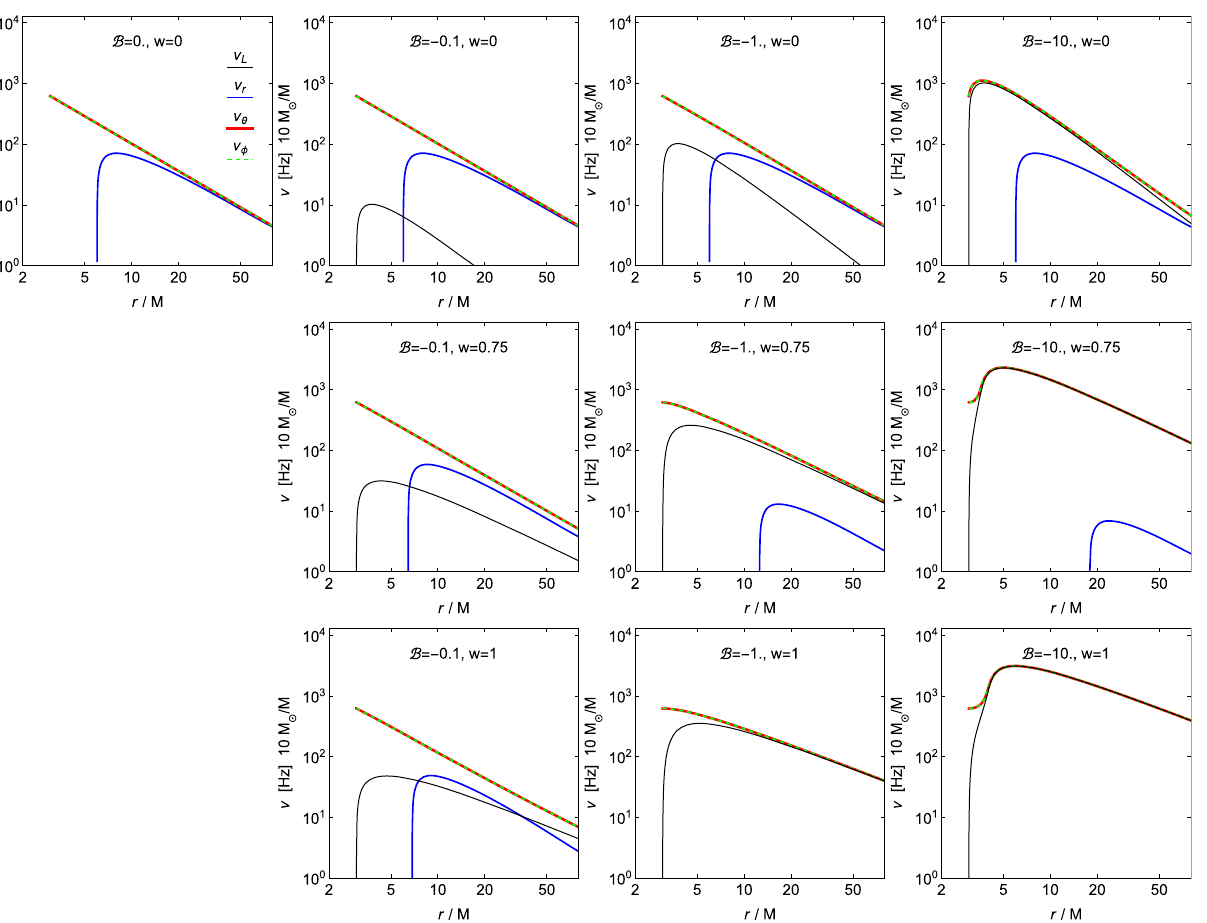
Fig. 14 Off-equatorial radial profiles of the frequencies of small harmonic oscillations ν r , ν θ , ν φ , and ν L of charged particle orbiting BH of the mass of M = 10 M (cid:4) in external parabolic MF for different values of the parameters B and w